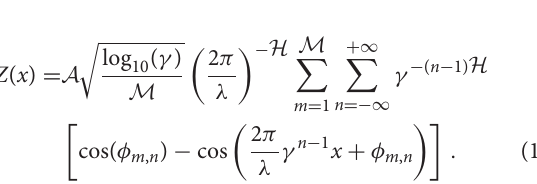
FIGURE 1 | (A) The chromosome C 1 ( x ) is visualized by the red line, and corresponds to the sum of the other colored co-sinusoids with n C 2 ( x ) corresponds to the set of co-sinusoids provided by the choice n